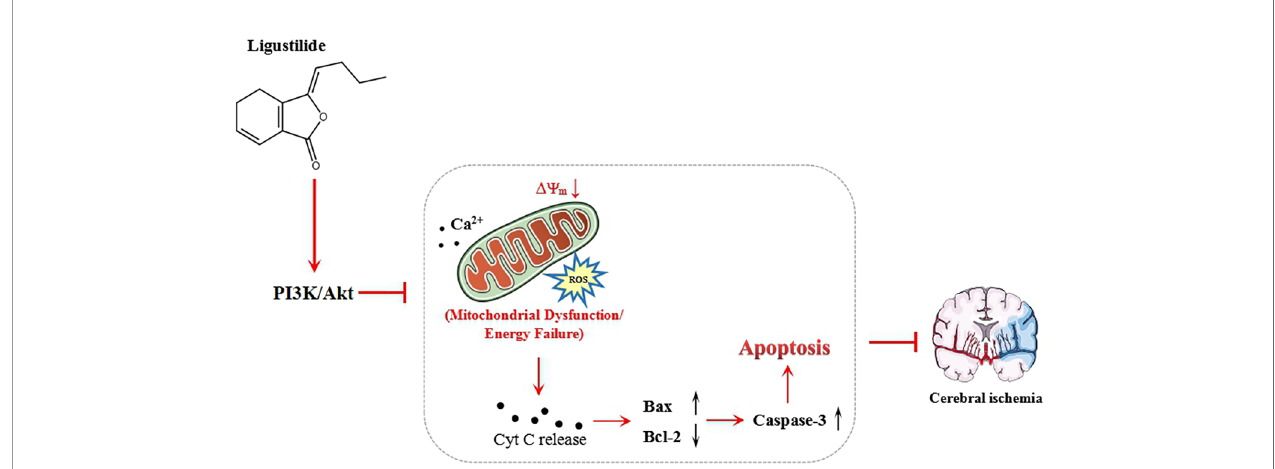
FIGURE 6 | Schematic showing the mechanisms of ligustilide reduce the cell apoptosis injured by oxygen-glucose deprivation/reperfusion